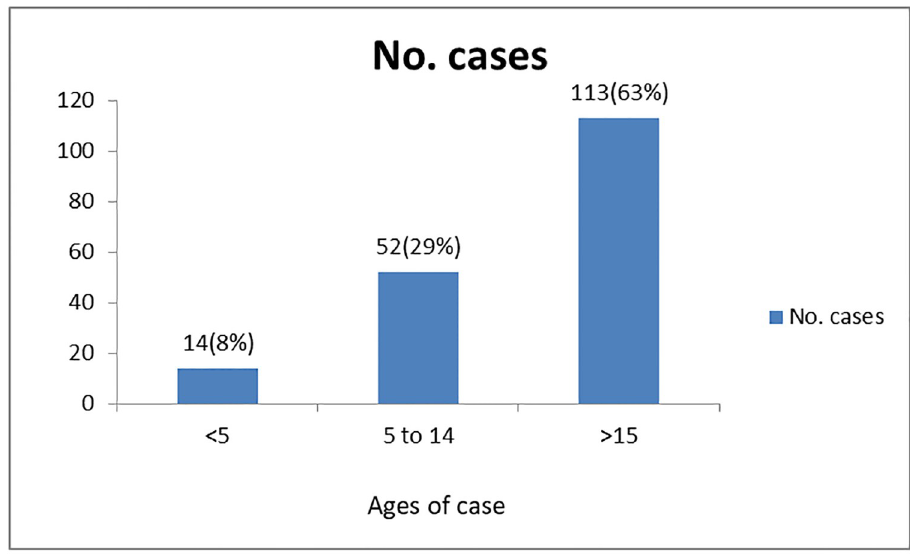
Fig 1. HVOD case by age categories in Tahtay koraro district from September 2006 to August 2016.